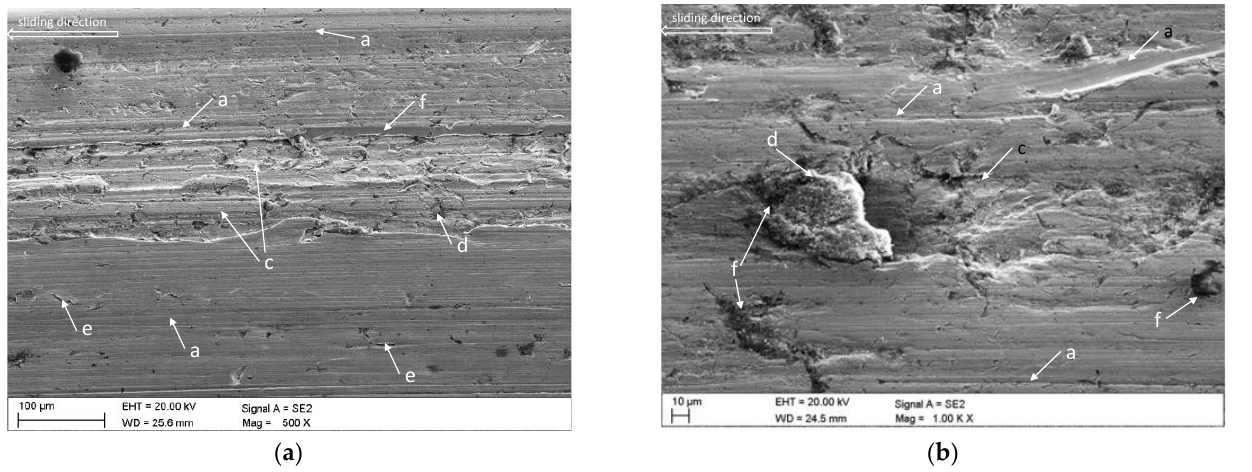
Figure 11. Views of WRS_400 steel surface (SEM) after the tests with a mixture of 75% coal and 25% quartz sand (Variant IV), view of the fatigue chipping ( a , b ); symbols: a—grooves, c—delamination, d—debris, e—surface crack (exfoliation), f—coal-filled surface damage.